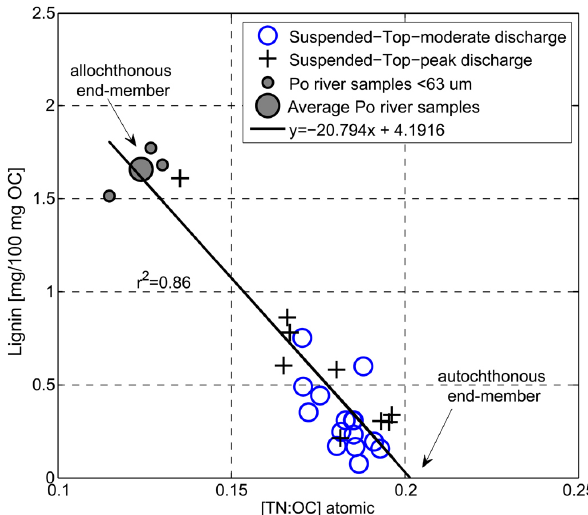
Fig. 11. Plot of TN:OC vs. lignin. Open circles and crosses are surface suspended sediments collected during moderate and peak flood, respectively. Filled circles are fine material ( < 63µm) col- lected in the Po river. Solid line is the regression